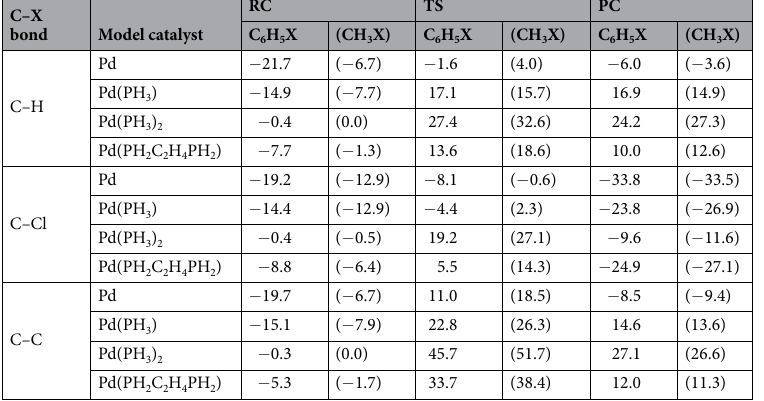
Table 1. Electronic energies [a] of stationary points relative to separate reactants (in kcal mol − 1 ) for the oxidative addition of arylic (C 6 H 5 X) [b] and aliphatic (CH 3 X) [c] C–H, C–Cl, and C–C bonds to various model catalysts. [a] Computed at ZORA-BLYP/TZ2P. [b] This work. [c] From refs 16,17,19